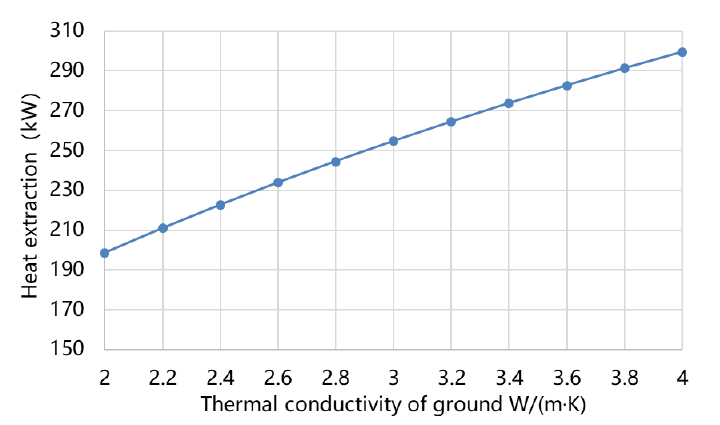
Figure 15. Effect of ground thermal conductivity on the heat extraction of DBHEs.